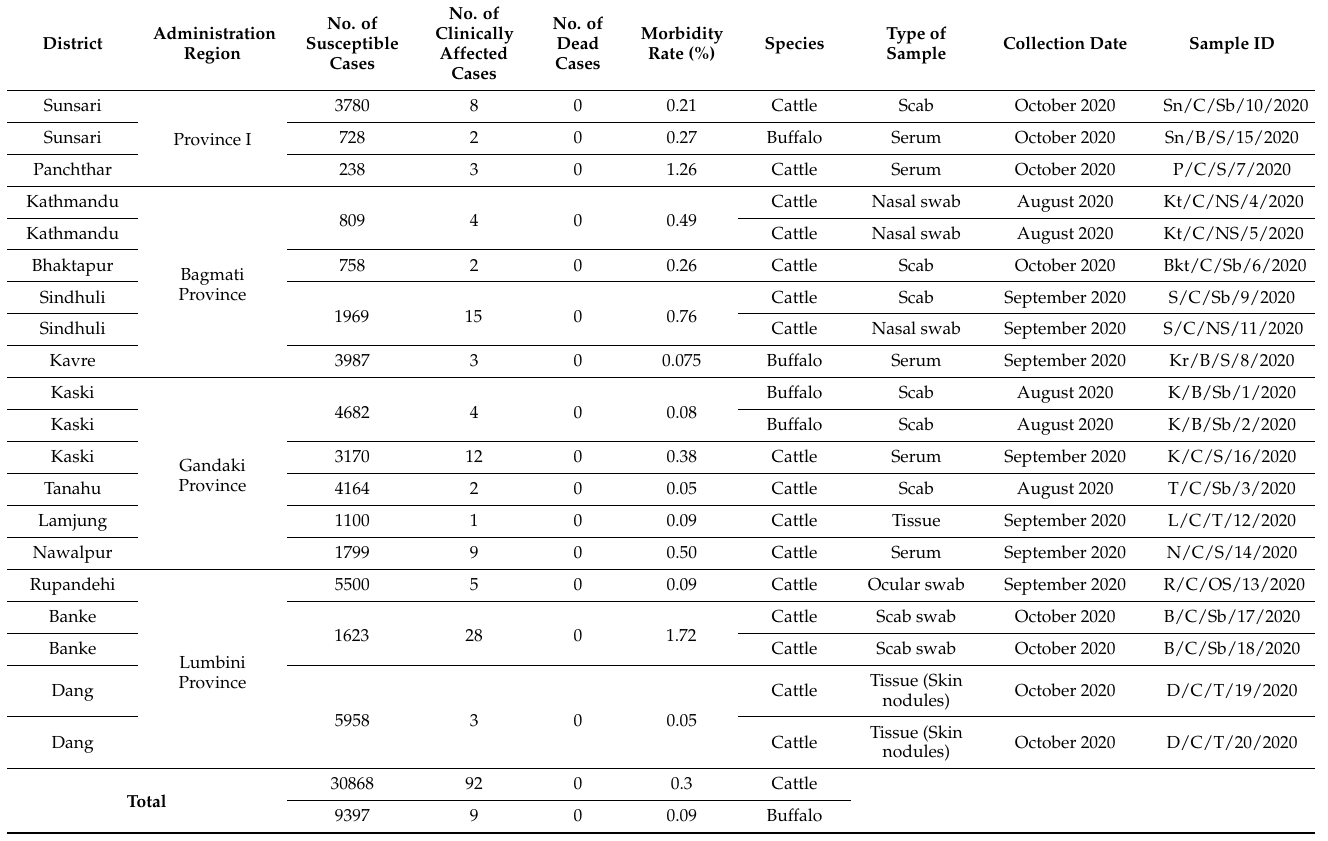
Figure 1. Map showing the geographical locations and sample size of the LSD-affected districts in Table 1. Features of the LSD outbreak in Nepal in cattle and buffaloes between August and October